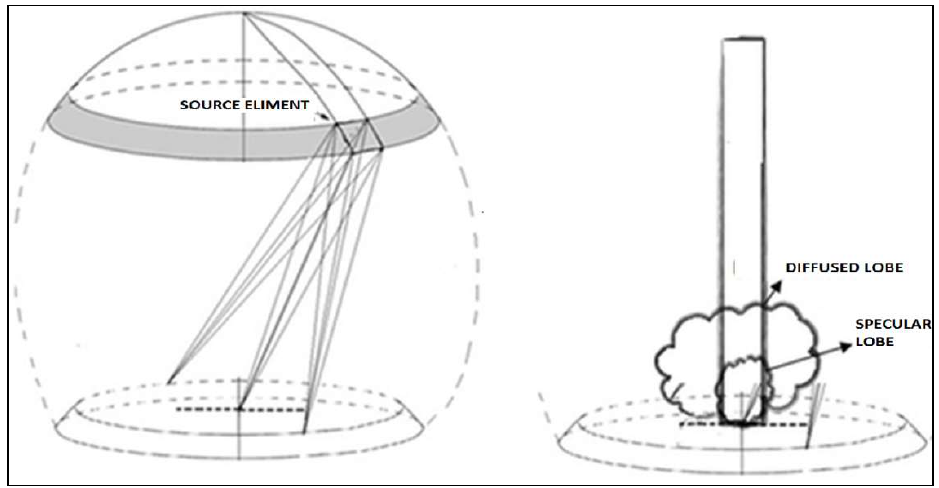
Figure 2. Diffused and specular reflection in the integrated sphere with concentric illumination.